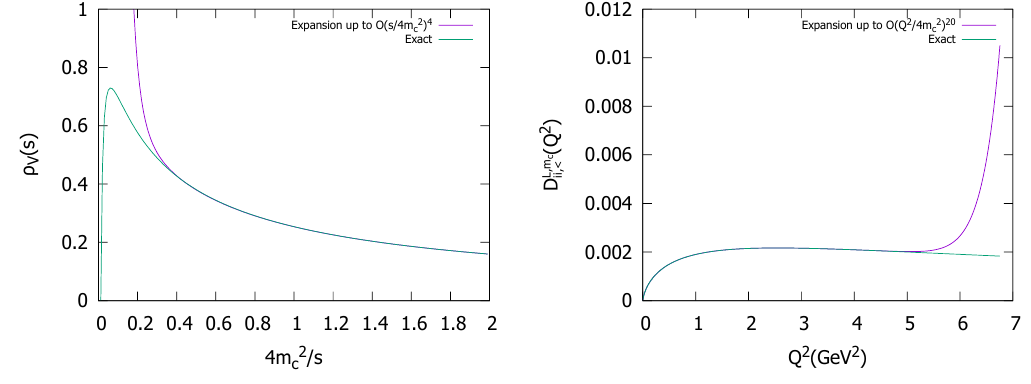
) = 0 . 115 (left) and 0 . 120 (right). Z